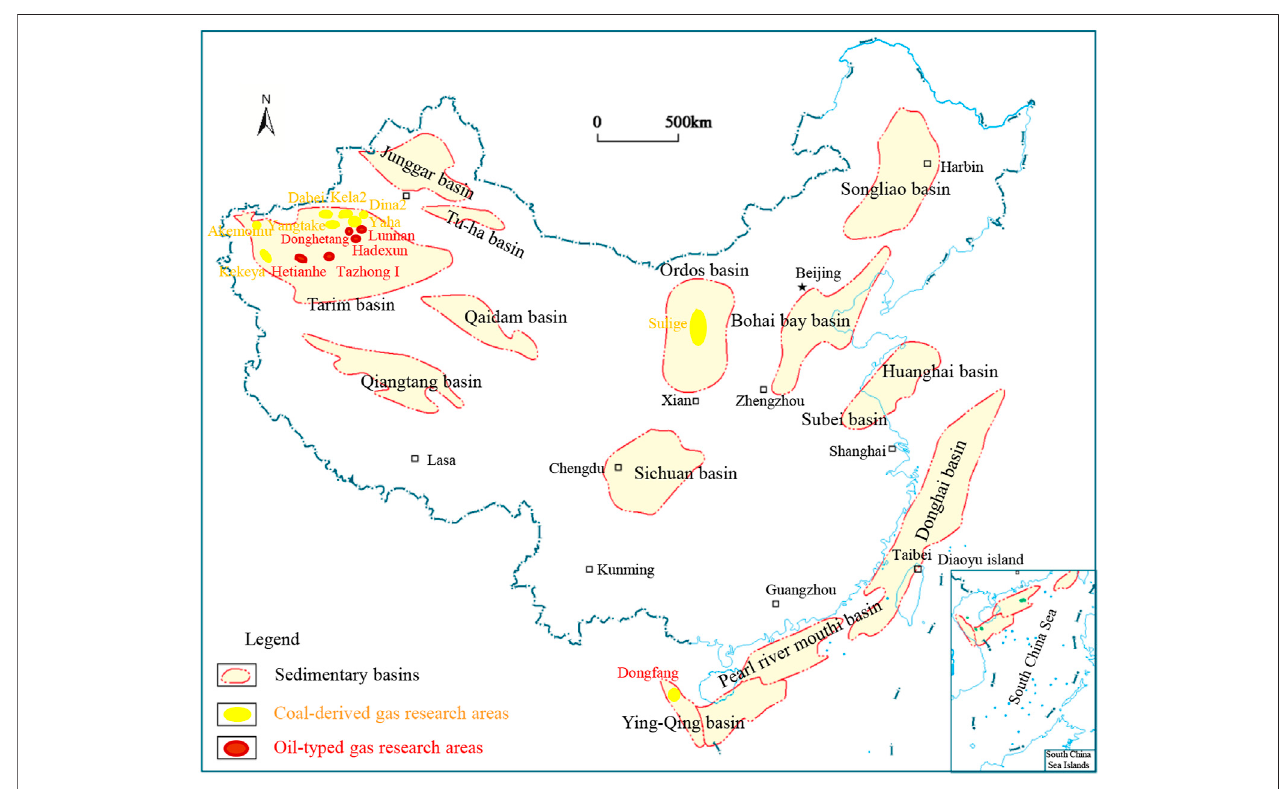
FIGURE 1 | Research areas of coal-derived gas and oil-typed gas on gas-bearing basins in China.